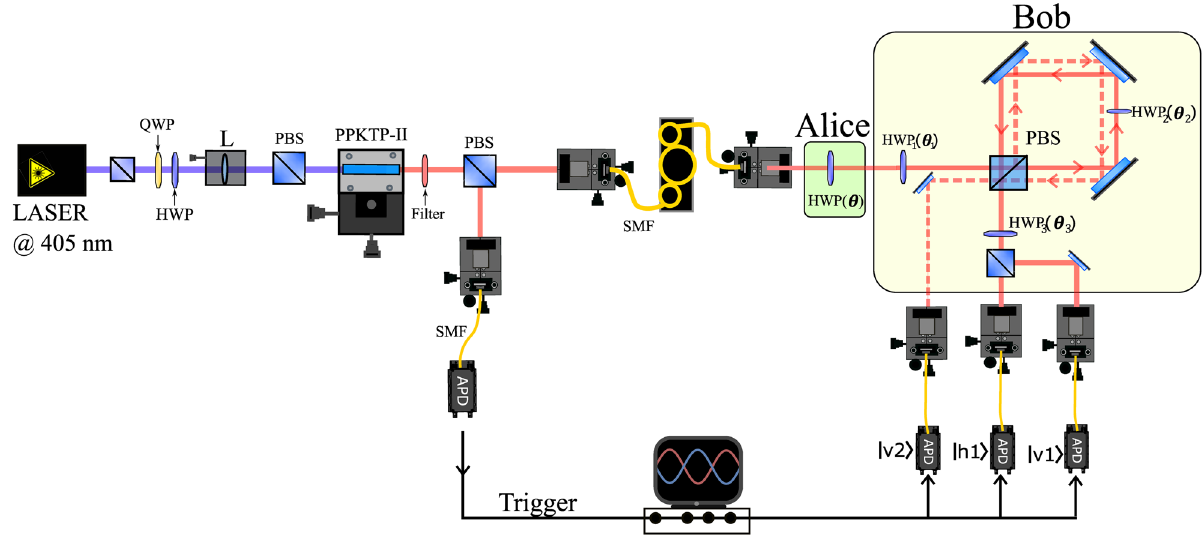
Figure 1. Experimental setup used to implement FRIO quantum state discrimination. Alice can prepare the φ i non-orthogonal state using the half-wave plate HWP (θ) , encoding on a single photon generated at the � | heralded source based on the SPDC process. Bob uses a two-path Sagnac interferometer to perform the three- outcomes POVM needed for the chosen discrimination strategy covered by the FRIO scheme. Each outcome is associated with success, error, and inconclusive results. In particular, for intervals I and II, the inconclusive φ 1 V 2 V 1 outcome Q is detected in the spatial mode labeled by . Thus, the state is identified when is detected, � | | � | � φ 2 H 1 while the is associated to detecting in . See the main text for more � | | �